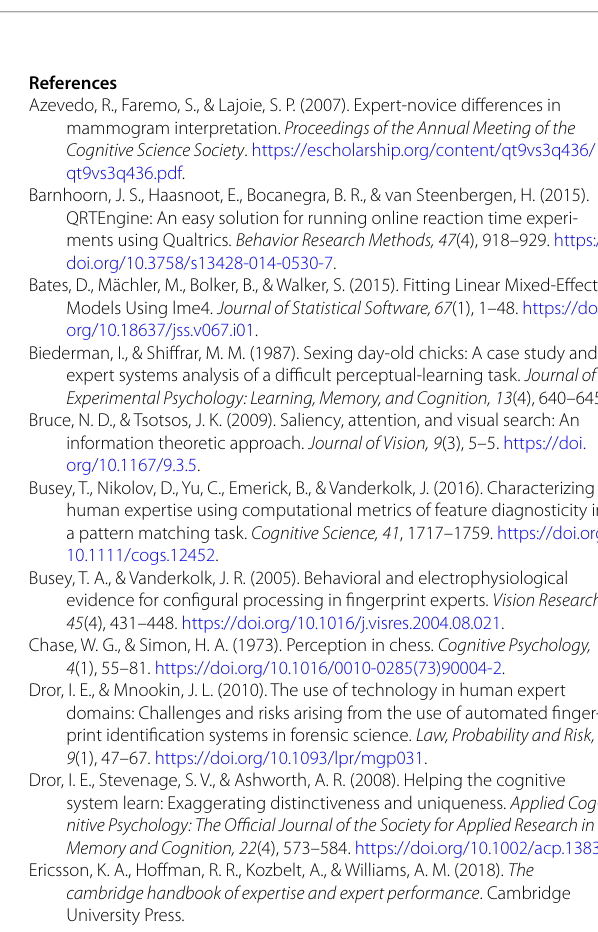
Fig. 12 Fingerprint match and non-match accuracy pre-to-post-training between novices and fingerprint examiners who received domain-specific and domain-general training in Experiment